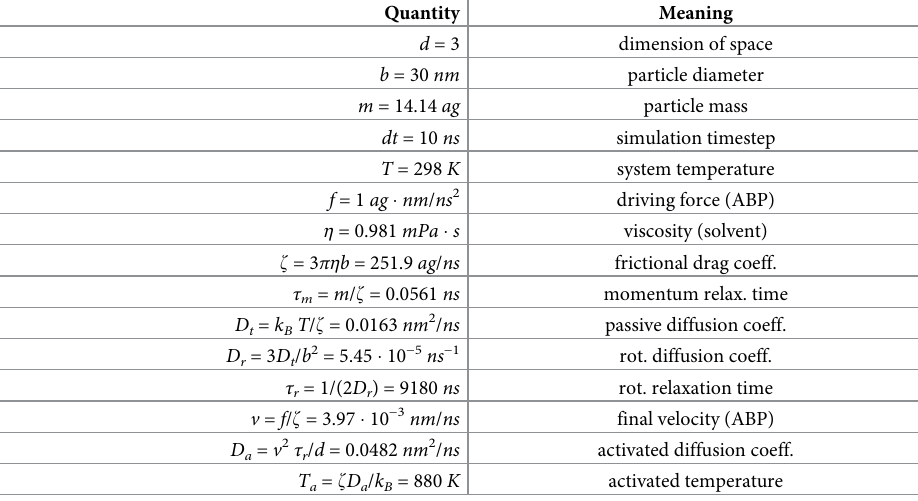
Table 1. Simulation parameters and derived